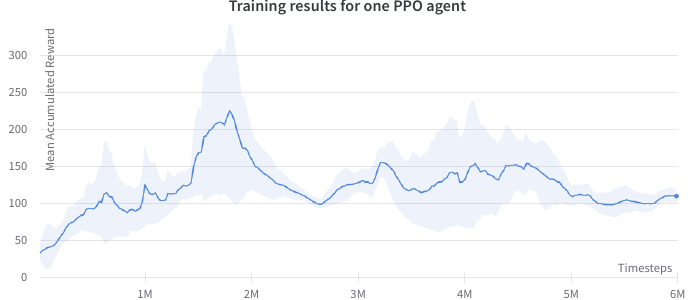
Figure 12. Progression of the mean accumulated reward for the decentralized single-agent PPO. Training results are reported for three experiments with different random seeds. The standard deviation of three runs is shown in the plot.